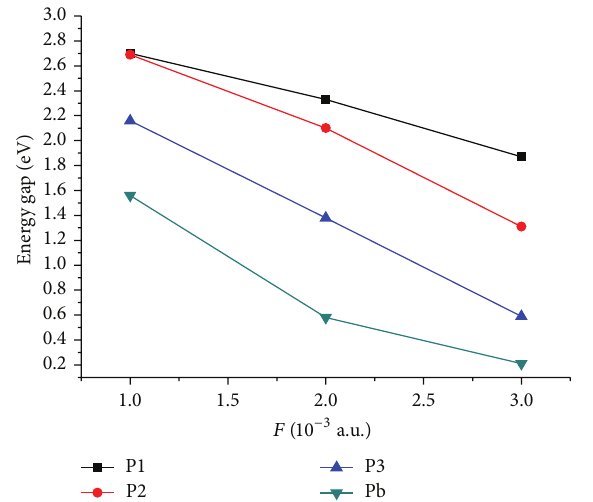
Figure 7: The changes of band gap of the dipolymers along with the increasing electric